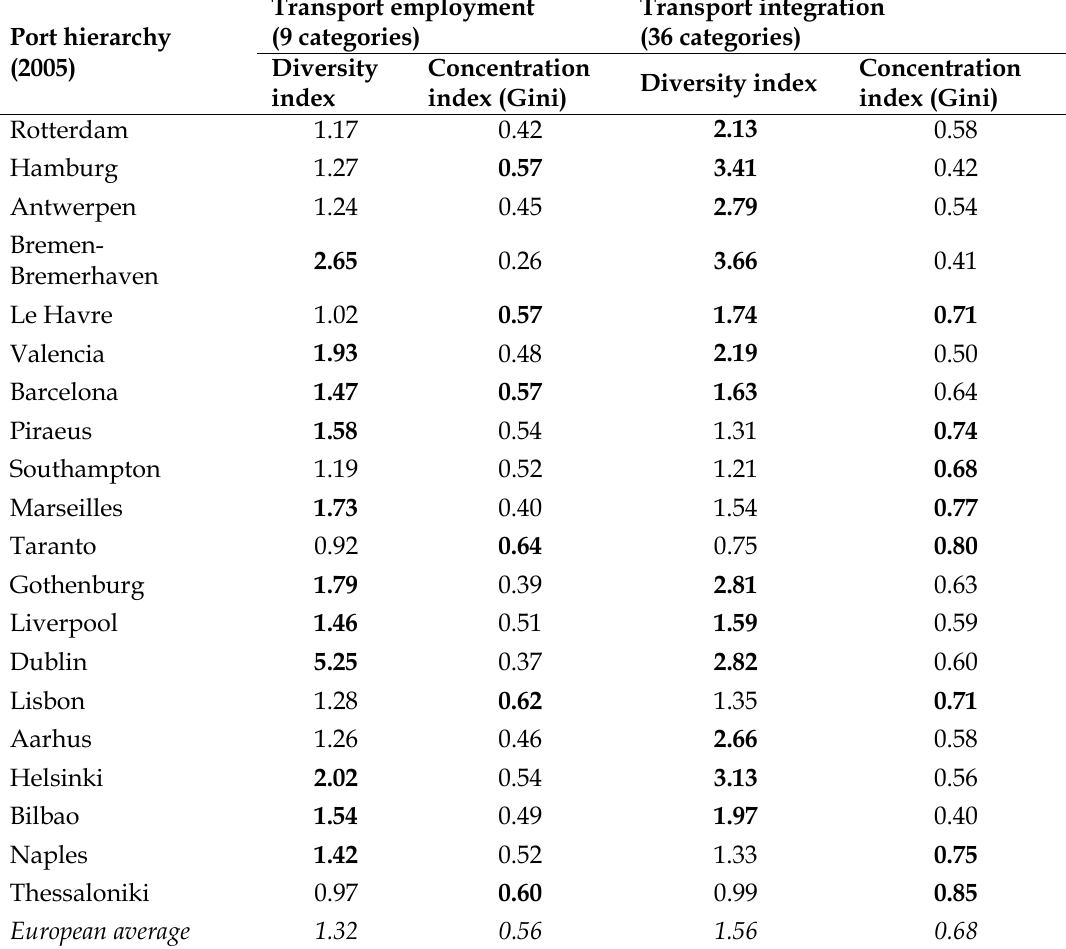
Table 6. Diversity and concentration at top 20 European container